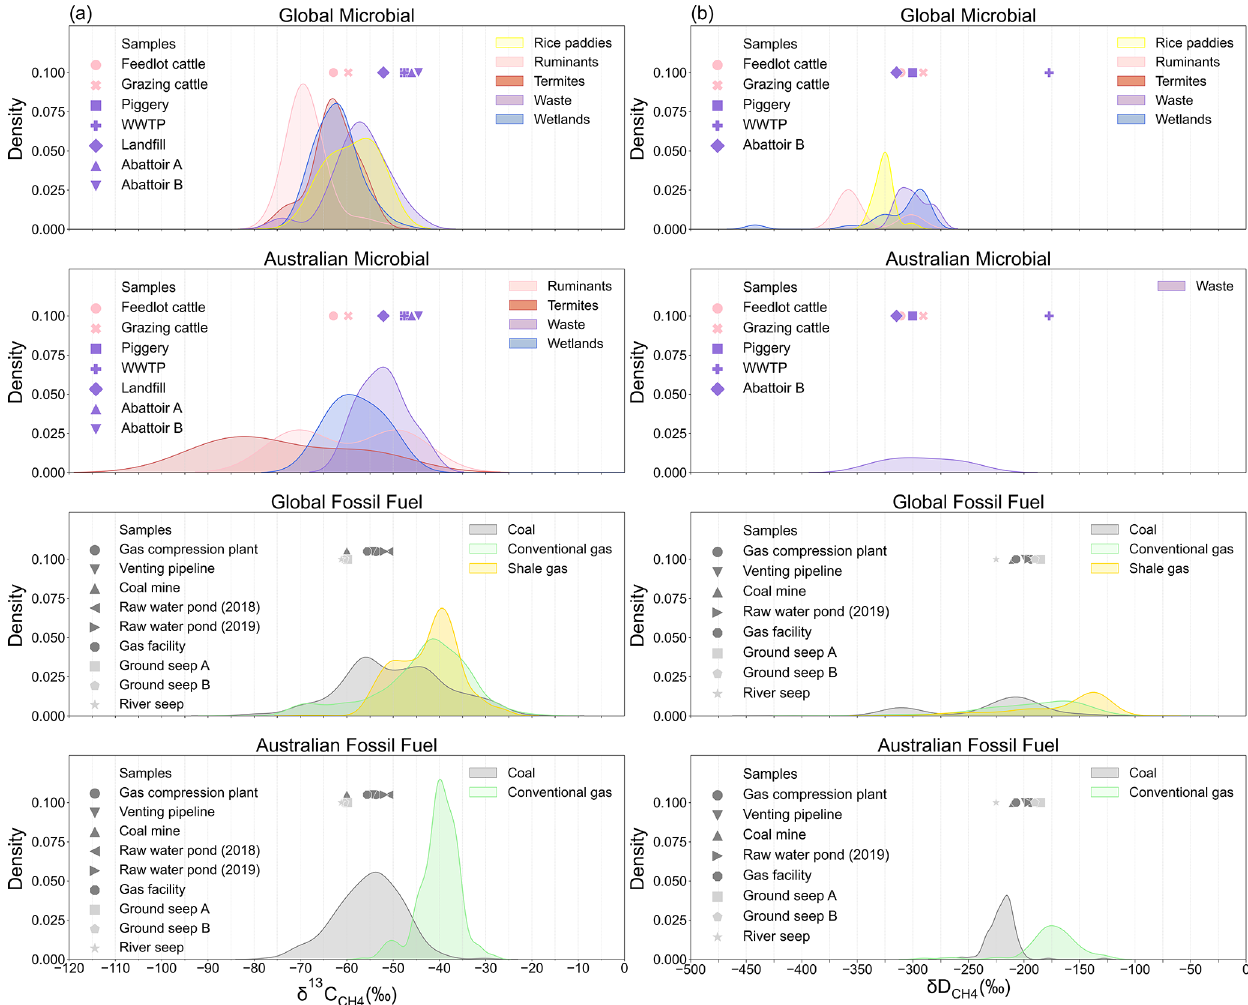
Figure 6. Probability density plot of literature values (globally and from Australia) for (a) δ 13 C CH study (global values taken from Sherwood et al., 2017, and literature sources listed in Table